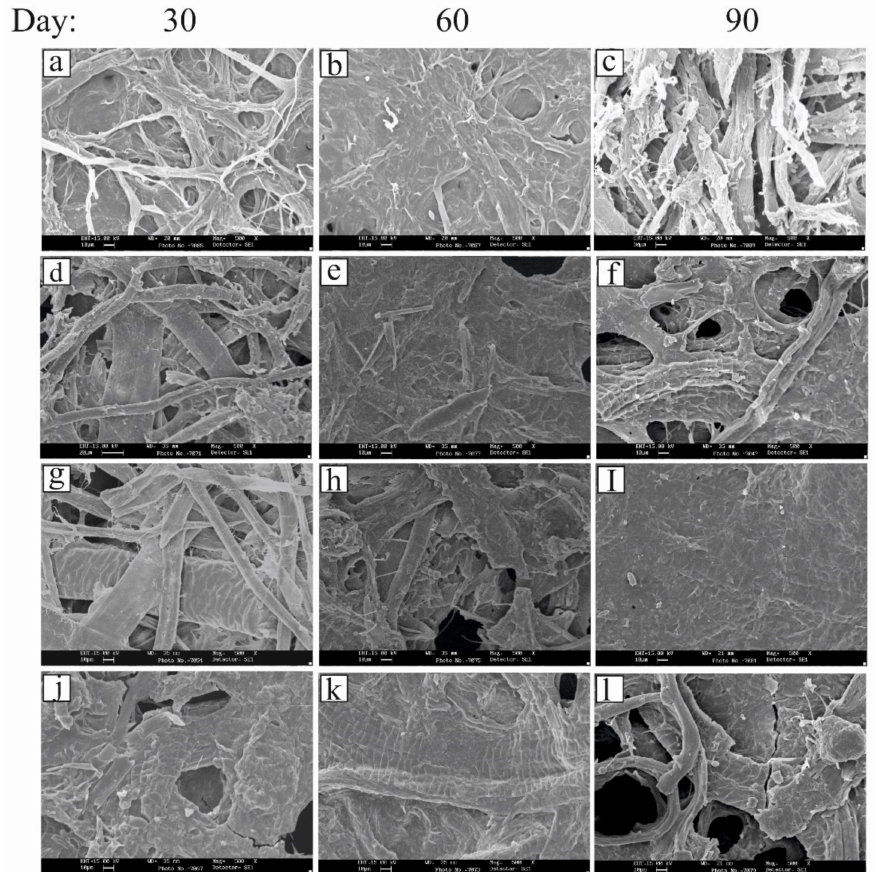
Figure 3. SEM analysis at 500 × magnification of kraft pulp/wool hydrolyzed bio composite after 30, 60, and 90 days of soil biodegradation: 100% kraft pulp biocomposite after ( a ) 30 days, ( b ) 60 days, and ( c ) 90 days; 50%-50% kraft pulp/140 ◦ C hydrolyzed wool biocomposite after ( d ) 30 days, ( e ) 60 days, and ( f ) 90 days; 50%-50% kraft pulp/150 ◦ C hydrolyzed wool biocomposite after ( g ) 30 days, ( h ) 60 days, and ( i ) 90 days; 50%-50% kraft pulp/160 ◦ C hydrolyzed wool biocomposite after ( j ) 30 days, ( k ) 60 days, and ( l ) 90